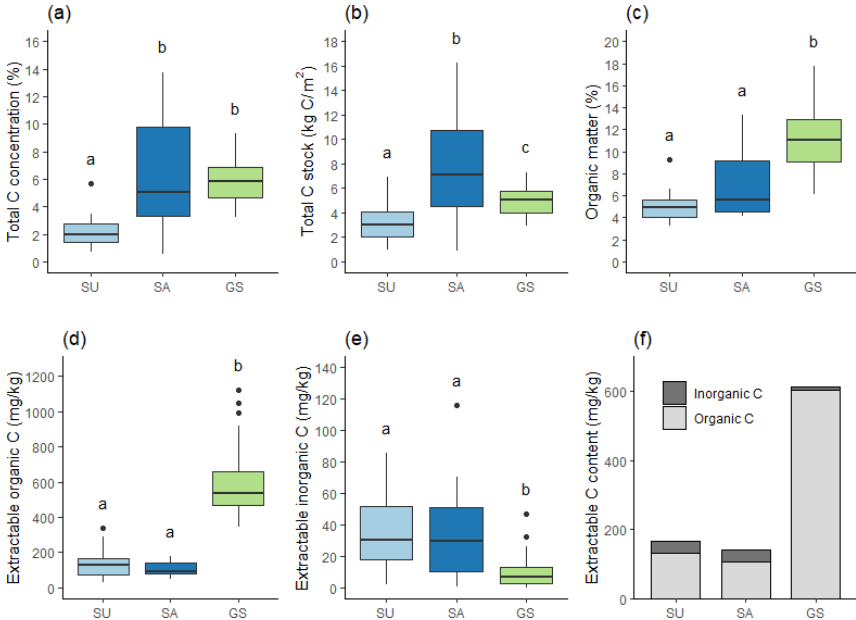
Figure 4. Carbon measurements: (a) total C concentration, (b) total C stock, (c) organic matter concentration, (d) K 2 SO 4 extractable organic C content, (e) K 2 SO 4 extractable inorganic C content, and (f) mean K 2 SO 4 extractable total C content; there are for SU ( n = 22), SA ( n = 14) and green space (GS; n = 32) soils. Stocks are calculated for the top 10cm of available soil. Different letters indicate a statistically significant difference between soil categories at the 0.05